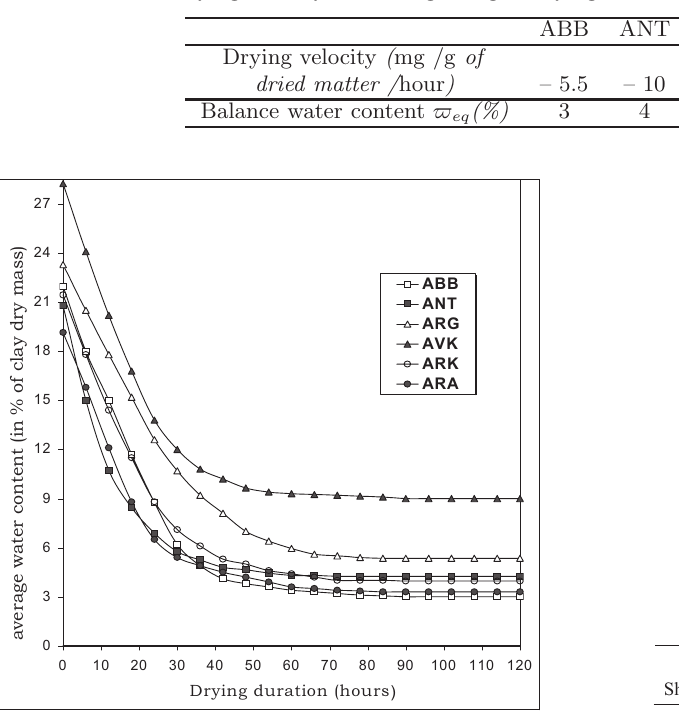
Table 1. Drying velocity at the beginning of drying and the balance water content at the end of drying.